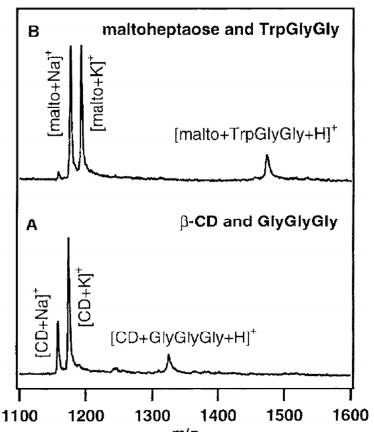
Figure 9 . MALDI-MS spectra of ( A ) β -CD and GlyGlyGly, 1 + 1 molar ratio, and ( B ) maltoheptaose and TrpGlyGly, 1 + 1 molar ratio. Reproduced from Reference [163] by permission of the PCCP Owner Societies.